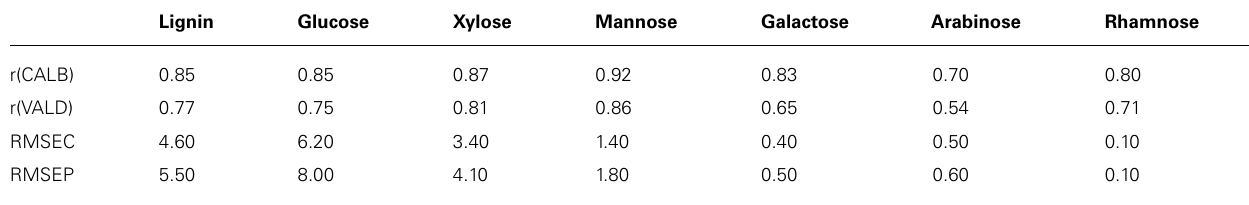
Lignin Glucose Xylose Mannose Galactose Arabinose